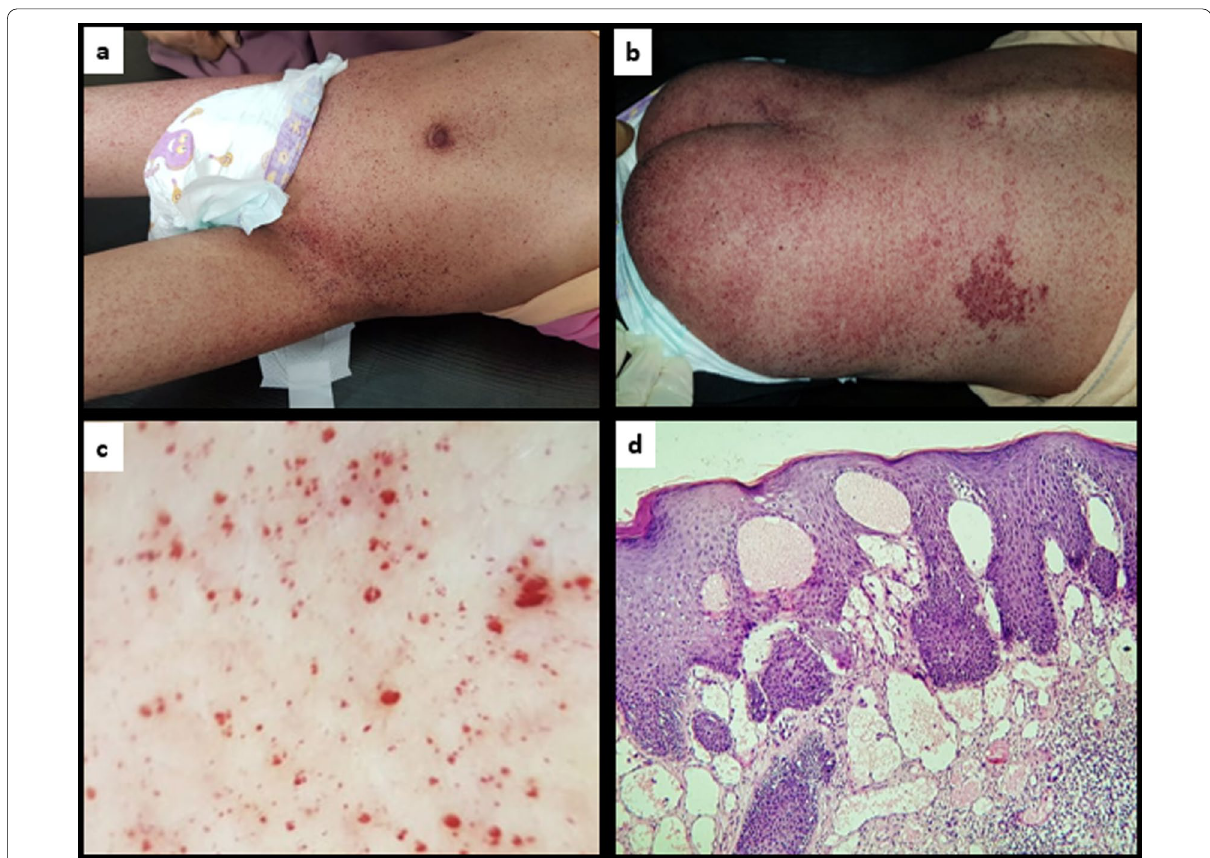
Fig. 1 a Multiple minute dark erythematous angiokeratoma papules on the trunk and thigh. b Disseminated angiokeratoma lesions on back and buttocks. c Dermoscopy of the multiple angiokeratomas revealing multiple small red lacunae. d Histopathological examination showing vascular ectasia of the papillary dermis with the epidermis encircling the dilated vascular spaces, and overlying epidermal hyperplasia characterized by acanthosis, elongation of the rete (H and E, ×